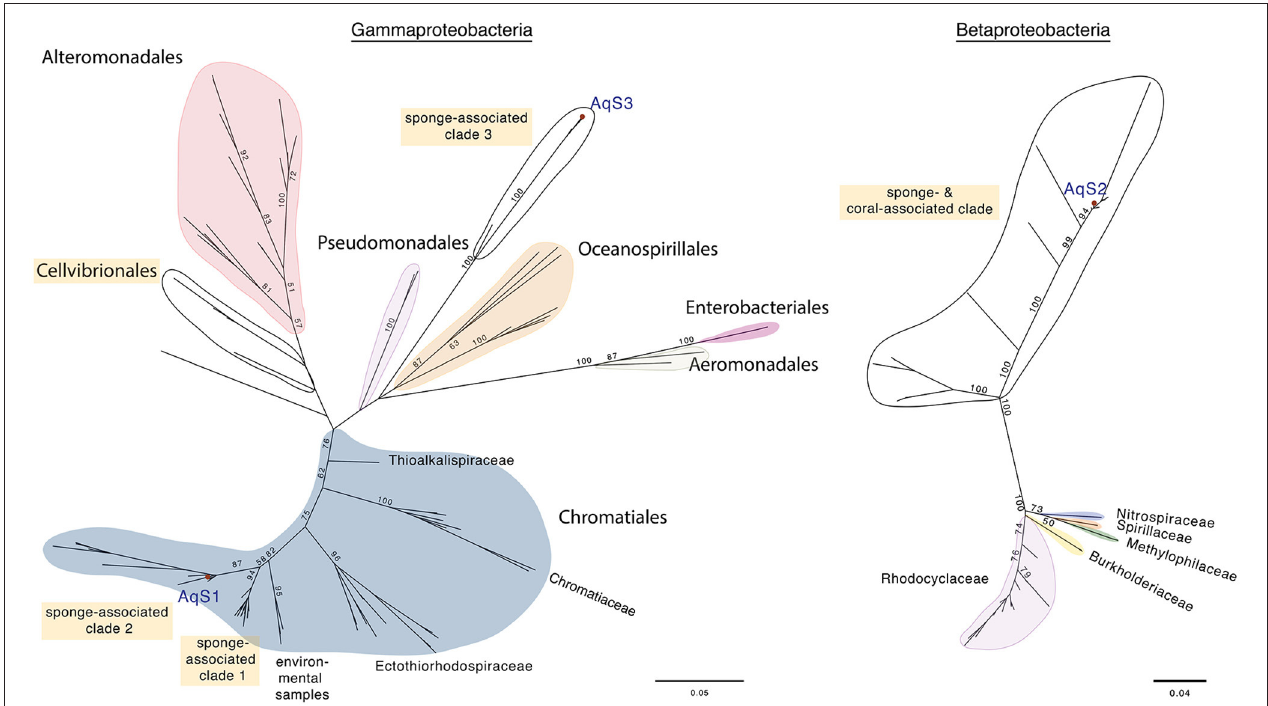
FIGURE 1 | Maximum-likelihood phylogenetic trees for AqS1 , AqS2 , and AqS3 . (A) The symbionts AqS1 and AqS3 are affiliated with the class Gammaproteobacteria. The AqS1 symbiont is recovered within the order Chromatiales in a sponge-specific clade; the nearest described species belong to the family Ectothiorhodospiraceae. The AqS3 symbiont clusters separately with bacterial clones derived from other demosponges in a clade located between the orders Pseudomonadales and Alteromonodales, but its phylogenetic placement is not well resolved. The detailed tree is presented in Figure S3. (B) The AqS2 symbiont sits within a large, well-supported sponge-specific cluster that is quite divergent from described families of the class Betaproteobacteria. The detailed tree is presented in Figure S4. The symbionts identified in A. queenslandica are indicated by a red dot and labeled as AqS1-3 . Bootstrap values > 50 are specified at major